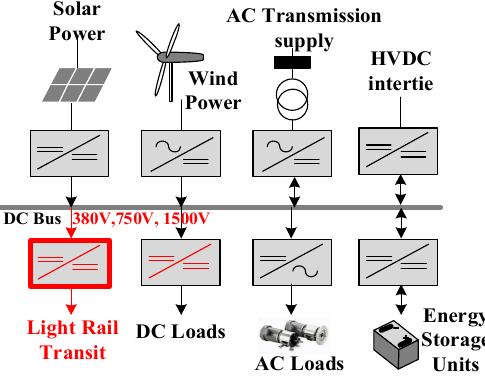
Figure 1. Simplified circuit schematic of a dc microgrid system.